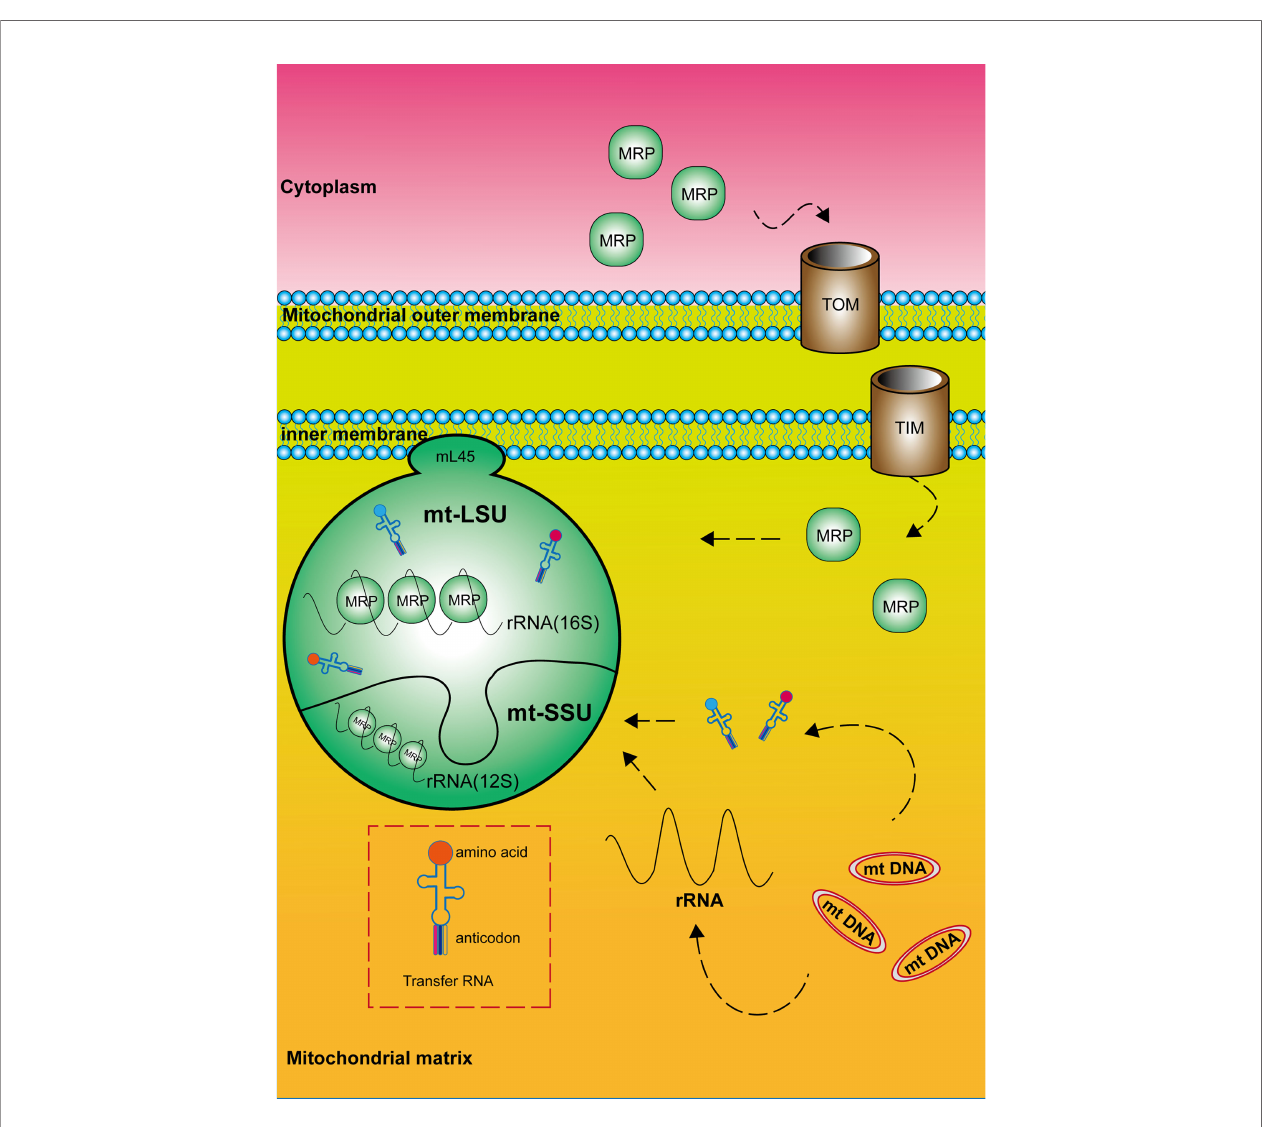
FIGURE 1 | Composition and structure of the mitochondrial ribosome. The mature mitochondrial ribosome, which consists of a large and a small subunit, is permanently anchored to the inner mitochondrial membrane by MRPL45 (mL45) of the large subunit. Mitochondrial ribosomal proteins are synthesized within the cytosol and enter mitochondria mediated by the transmembrane transport complex including Translocase of the Outer mitochondrial Membrane (TOM) and Translocase of the Inner Membrane (TIM). RNA components are encoded by mitochondrial